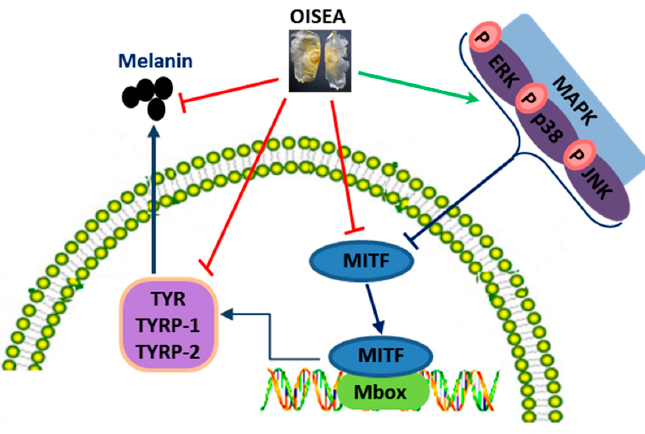
Figure 6. A proposed molecular mechanism of OISEA against melanogenesis process.